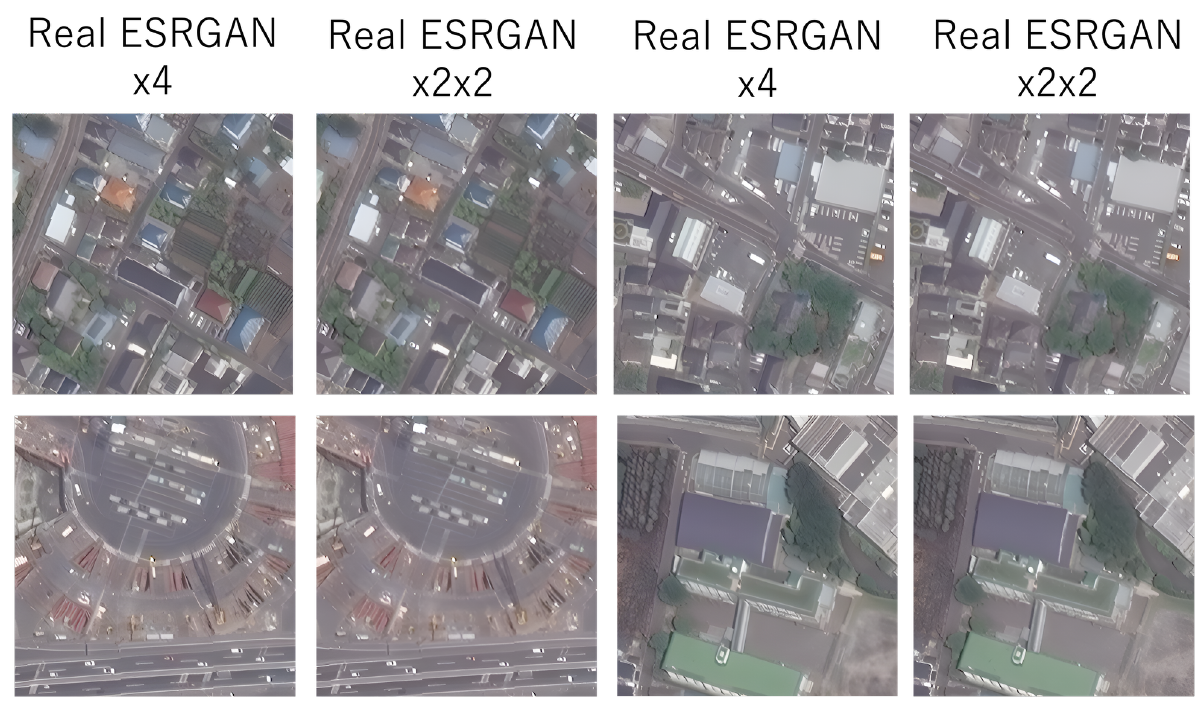
Figure 4. The comparison of the scale factor. The left figure shows the result of the trained model with a scale factor of 4. The right figure shows the results of two iterations of the trained model with a scale factor of 2. The images are obtained WorldView-2 sensor from